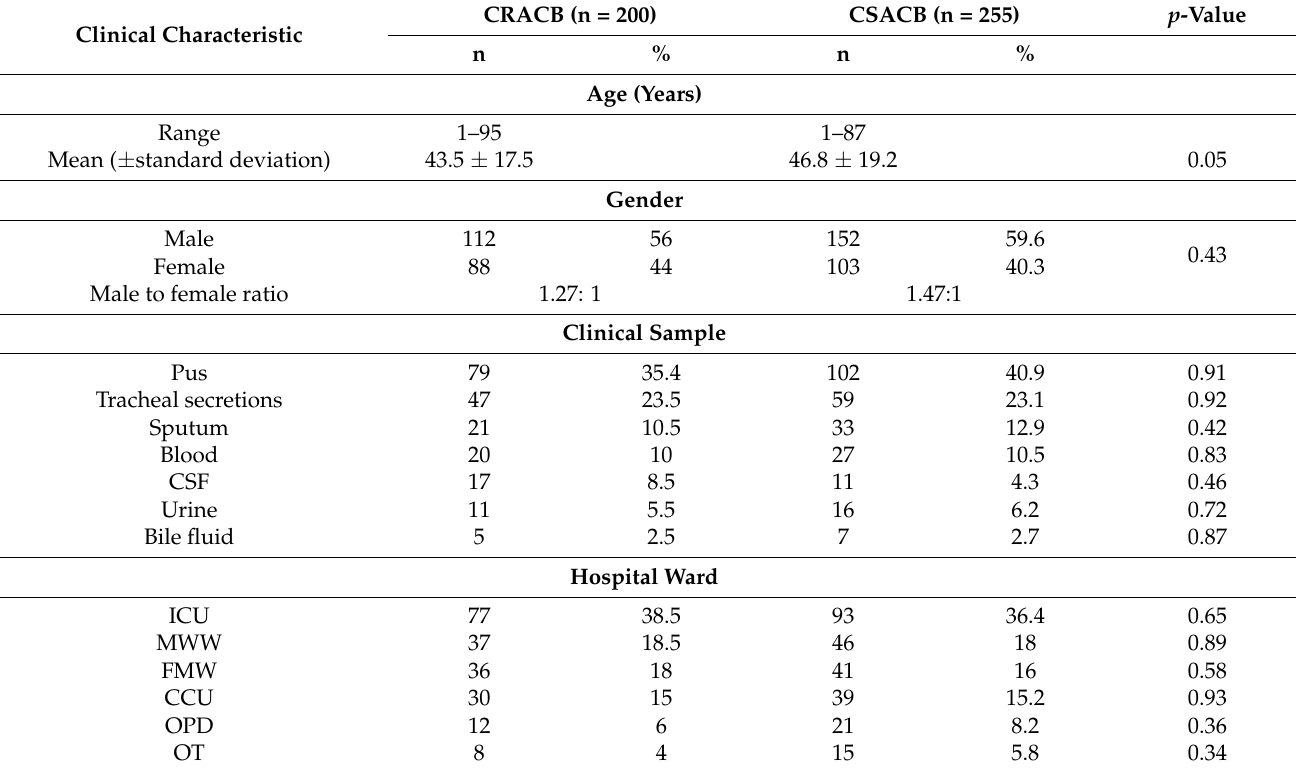
Table 1. Clinical characteristics and patient demographics of CRACB and CSACB